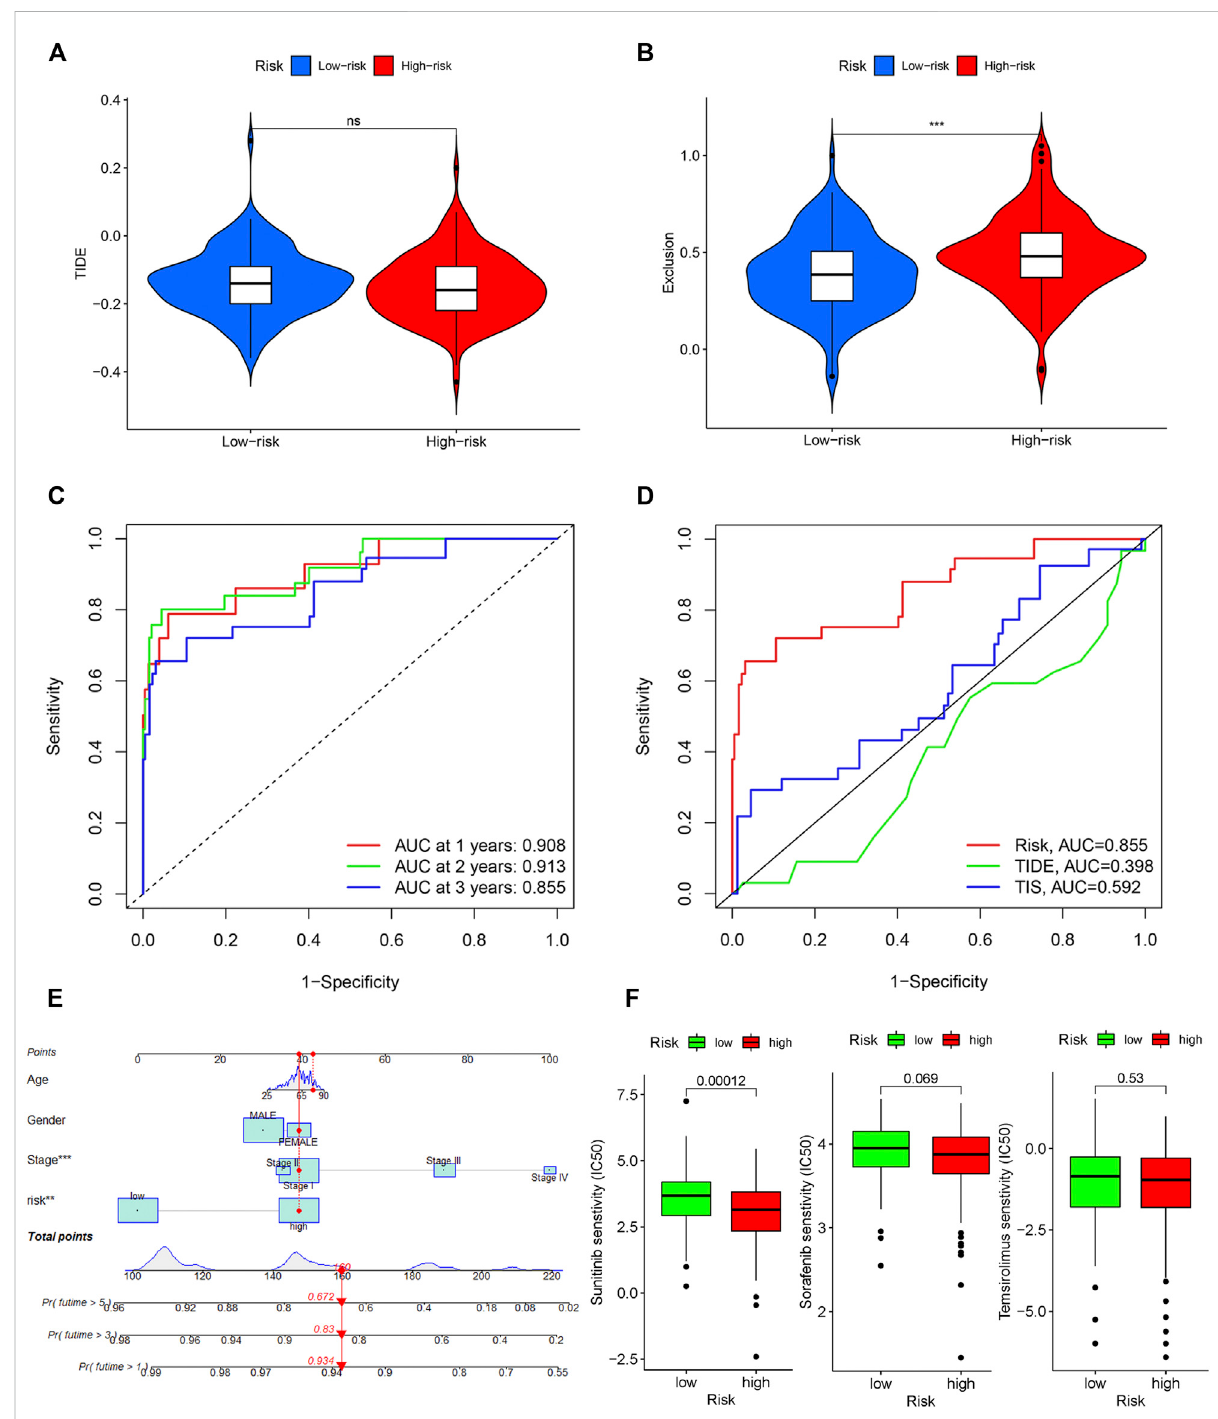
FIGURE 8 Evaluation of the IRGPI. TIDE (A) , and T-cell exclusion (B) score in different IRGPI subgroups. *** p < 0.001, ** p < 0.01, * p < 0.05. (C) Survival- dependent ROC curve analysis of the prognostic value of the IRGPI at 1, 3, and 5 years. (D) Survival-dependent ROC curve analysis of the prognostic value of IRGPI, TIS and TIDE at 3 years. TIS, T cell in fl amed signature; TIDE, tumor immune dysfunction and exclusion; IRGPI, immune-related gene prognostic index. (E) Nomogram for predicting 1, 3 and 5 years overall survival for PRCC patients. (F) Box plots of differentially targeted drug sensitivities between two